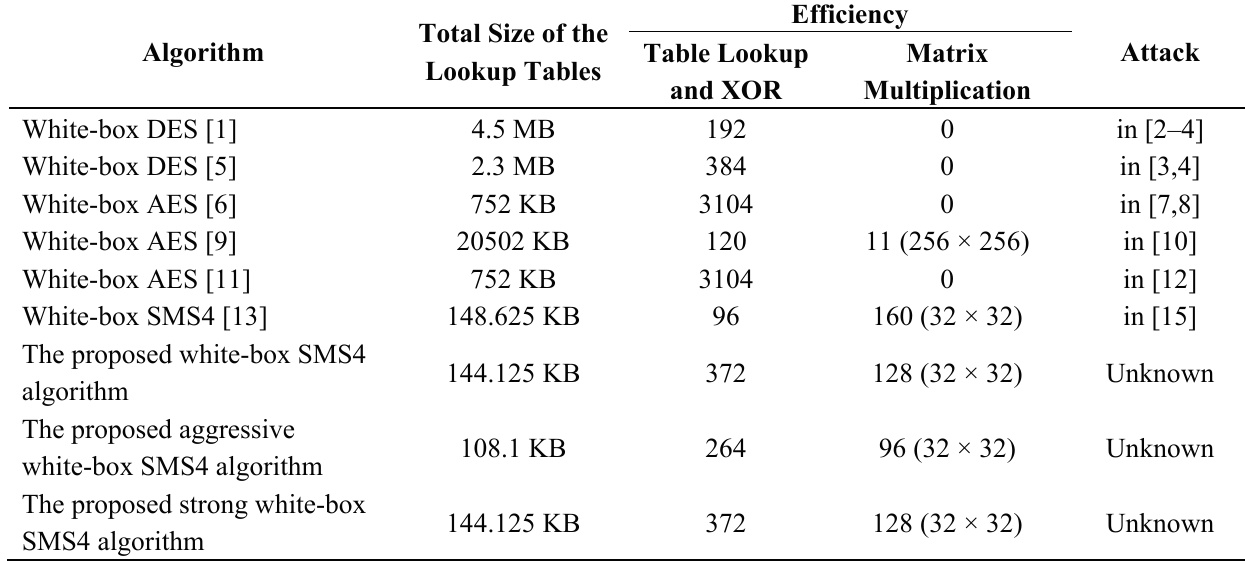
Table 2. A comparison of white-box encryption